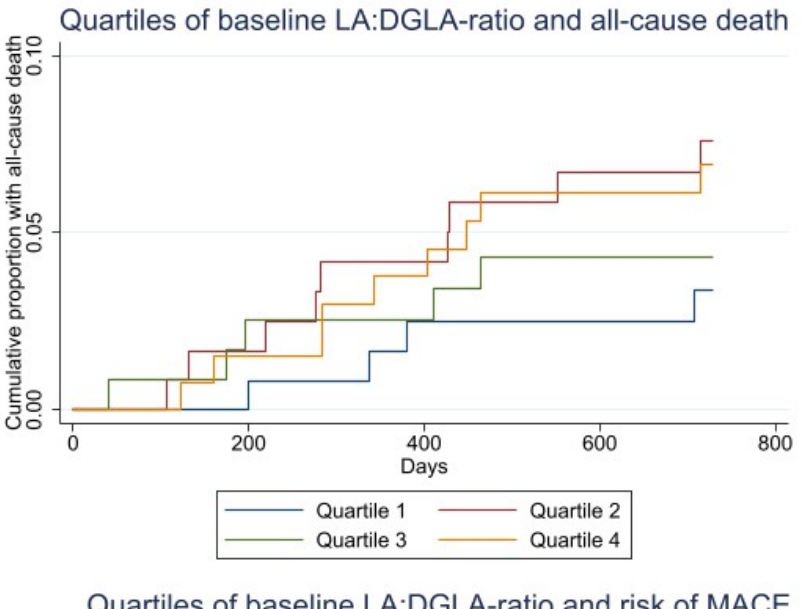
LA:DGLA Quartile 1 LA:DGLA Quartile 2 LA:DGLA Quartile 3 LA:DGLA Quartile 4 p -Value for Trend n = 1002